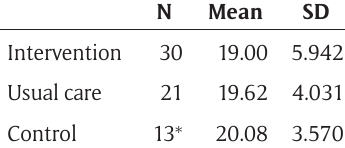
Table 6: Comparison of the mean and standard deviation (SD) Variation in Readiness to Change (T3-T1) scores between